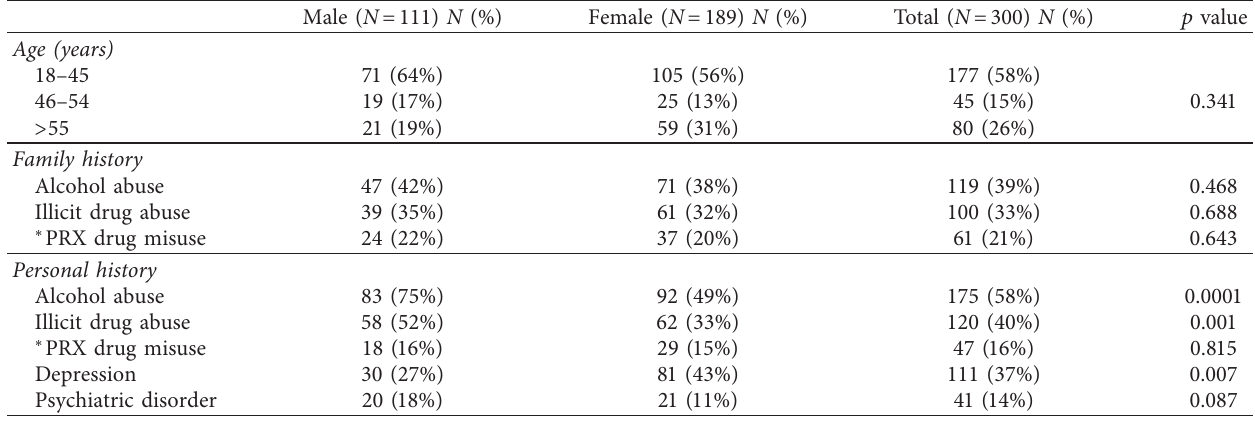
Table 1: Gender differences in opioid abuse risk factors among the emergency medicine population.